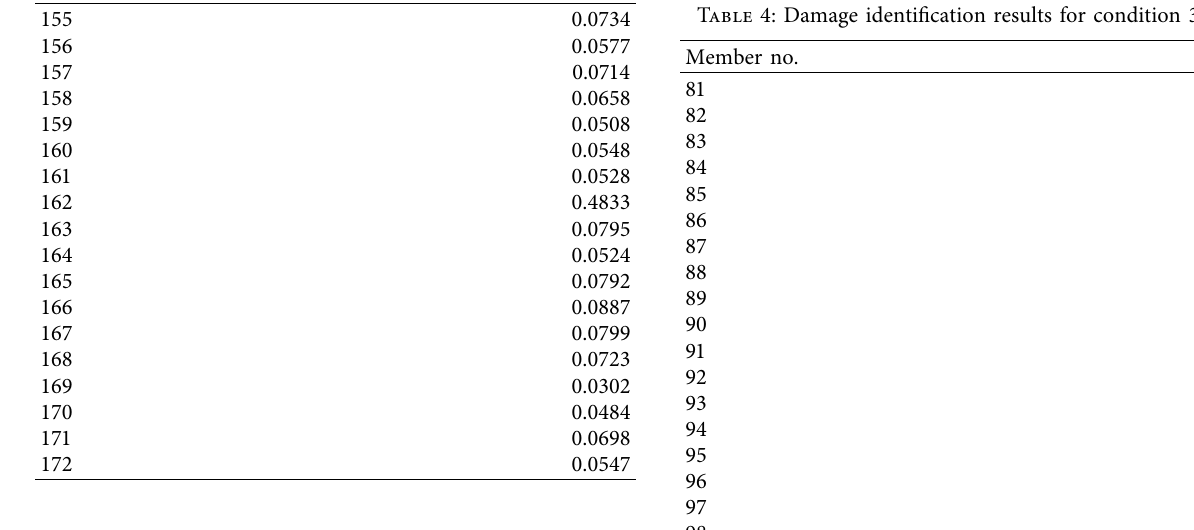
Figure 4: Particle iteration diagram for working condition 2. Table 2: Damage identification results of condition 1 (part). Member no.